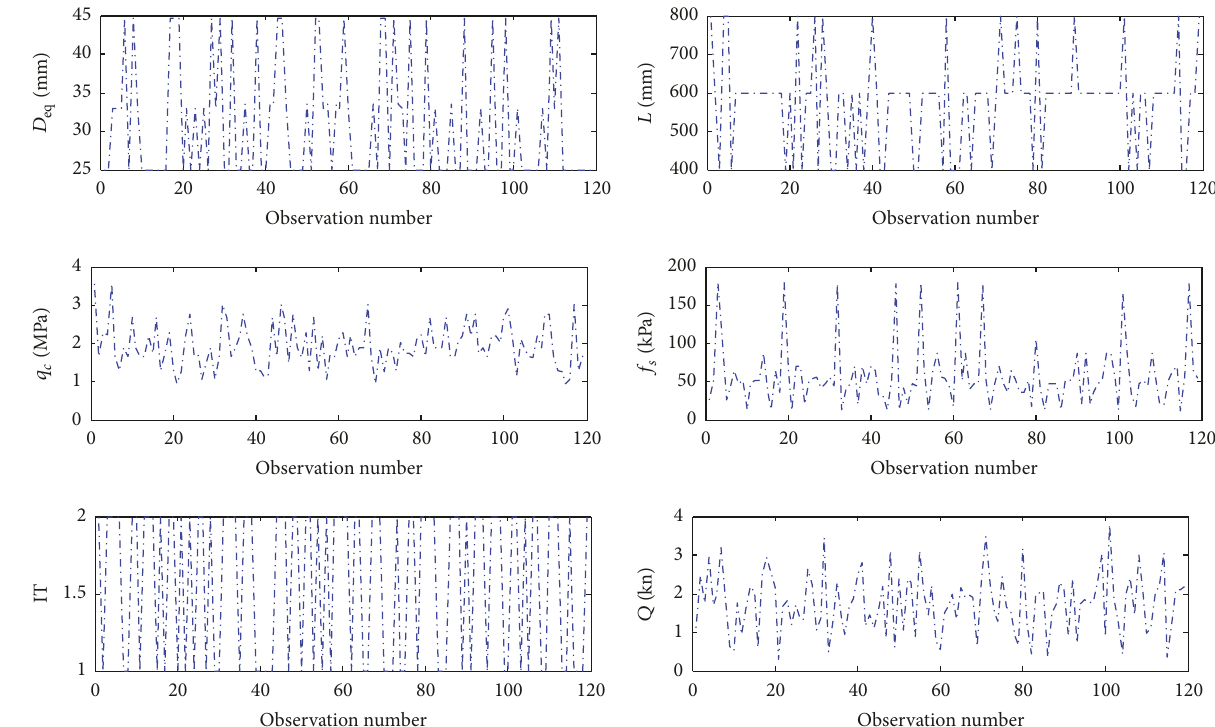
Figure 3: Database for field pullout tests (from Samui et al.